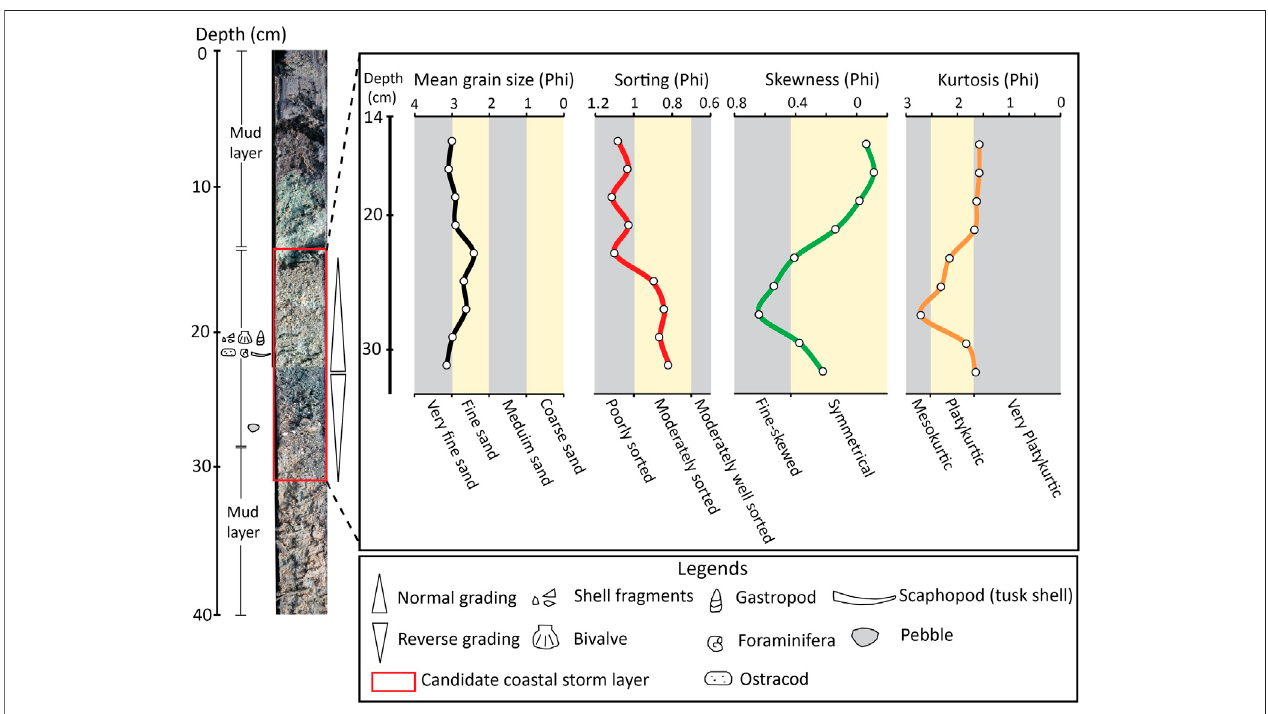
FIGURE 7 | Top layer of the candidate storm deposit recognized from core 3, showing the sharp contact with the mud layer underneath. Candidate storm sediments were characterized by medium sand that is poorly to very poorly sorted, similar to deeper candidate storm characteristics (see Figure 4 ).